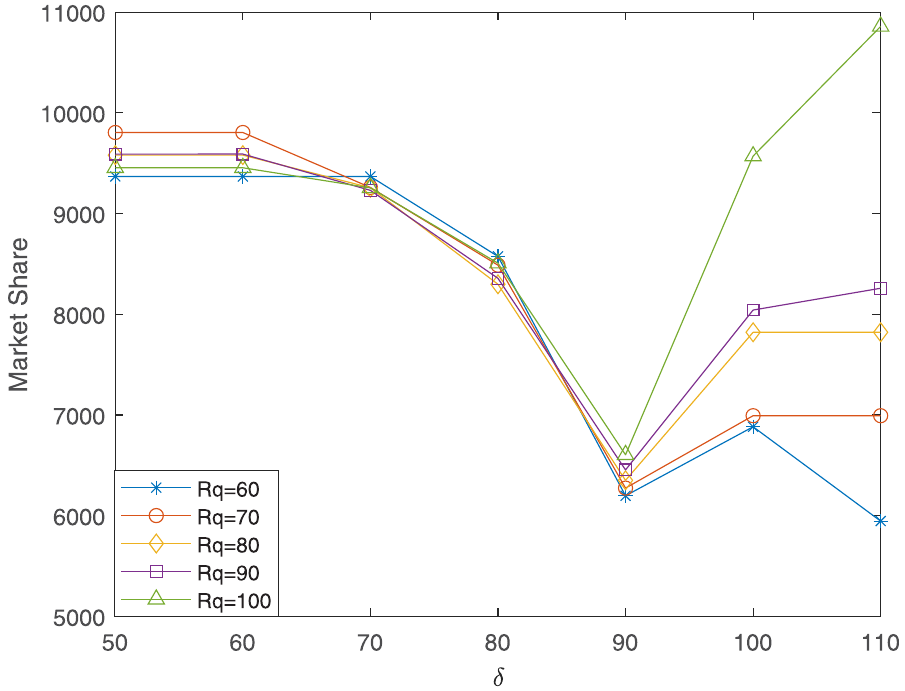
Fig 7. The relationship between market share and δ ( R c = 40, γ 1 = 0.4, γ 2 =